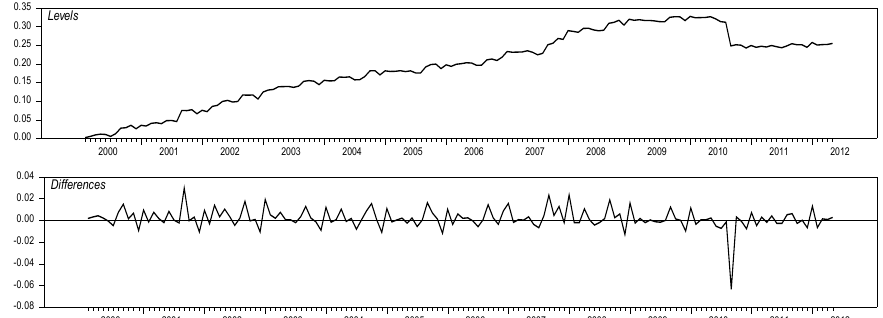
Figure 12. Consumer price index in the Eurozone 𝐼(1) . Data vector January 2000 to May 2012 (Great Depression).